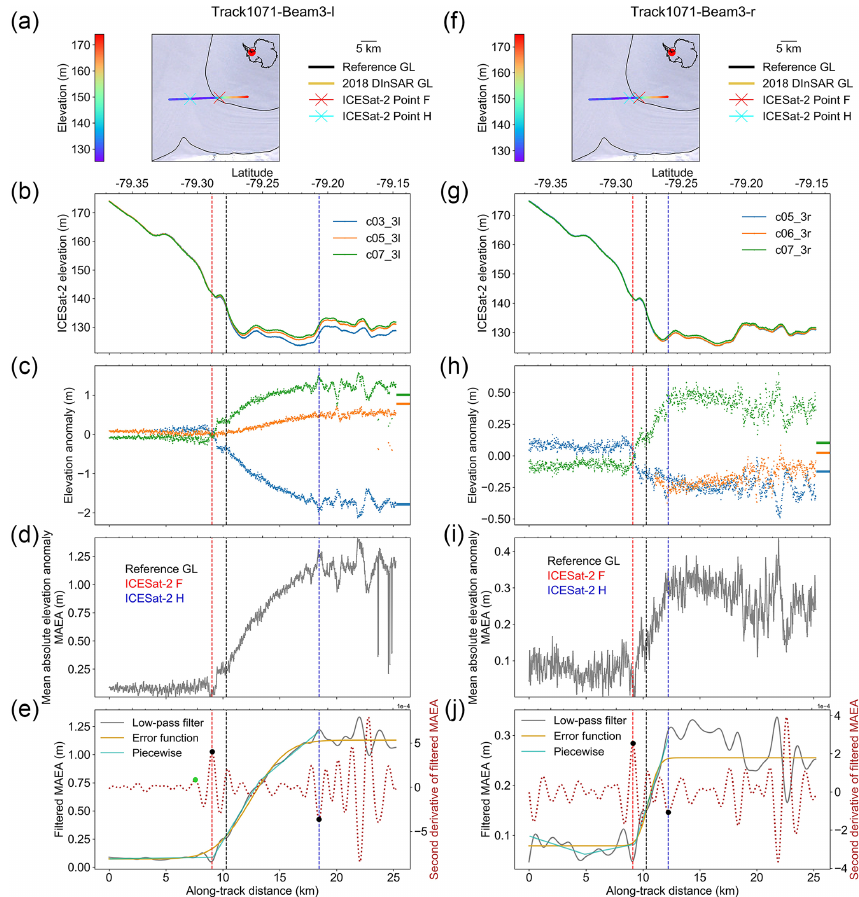
Figure 14. Comparison between the inshore limit of hydrostatic equilibrium (Point H) from repeat-track analysis for left and right beams of track 1071 located on the Skytrain Ice Rise under different ocean tidal amplitude ranges. Same as Fig. 3, (a) – e) show ICESat-2 repeat-track analysis for three left beams from repeat cycles 3, 5, and 7 in beam pair 3 of track 1071. (f–j) ICESat-2 repeat-track analysis for three right beams from repeat cycles 5, 6, and 7 in beam pair 3 of track